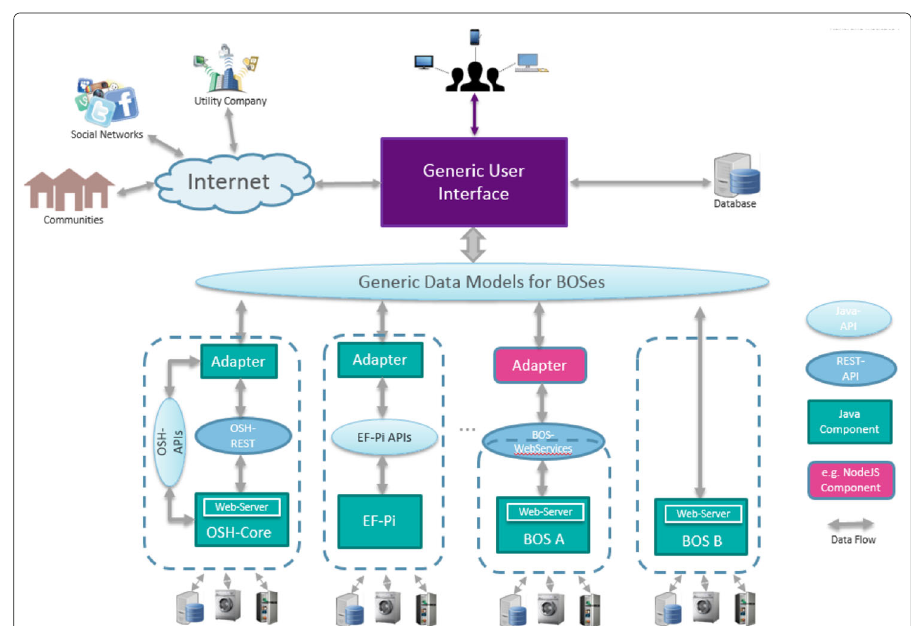
Fig. 1 Architecture of the generic user interface for building operating systems in smart